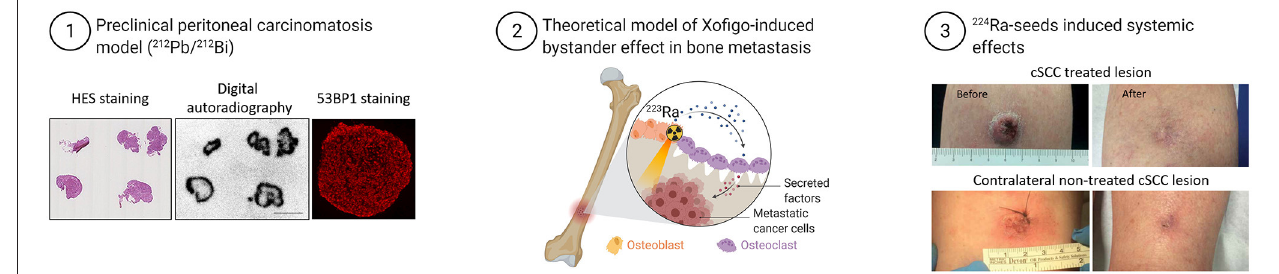
FIGURE 2 | Example of bystander effects at tissue scale and abscopal effects in patients exposed to TAT. Examples of bystander effects: (1) Strong heterogeneous distribution of radioactivity ( 212 Pb-labeled monoclonal antibodies) in tumors of mice treated with TAT was unexpectedly accompanied by homogenous distribution of DNA damage, measured by immunofluorescence analysis of 53BP1 expression ( modified from Ladjohounlou et al. ). (2) Model of 223 RaCl 2 (Xofigo)-induced bystander effects in a bone metastasis. (3) Systemic effect induced in a patient with cutaneous squamous cell carcinoma (cSCC) who received alpha brachytherapy to one tumor lesion. Surprisingly, another tumor lesion far from the radiation area also was cured (66) ( modified from Bellia et al.